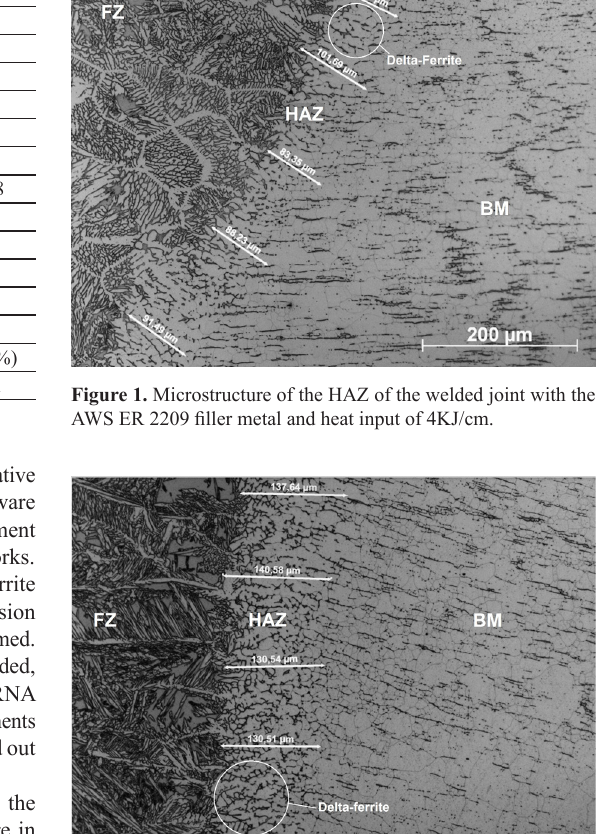
Table 2. Welding parameters adopted. Welding Parameters